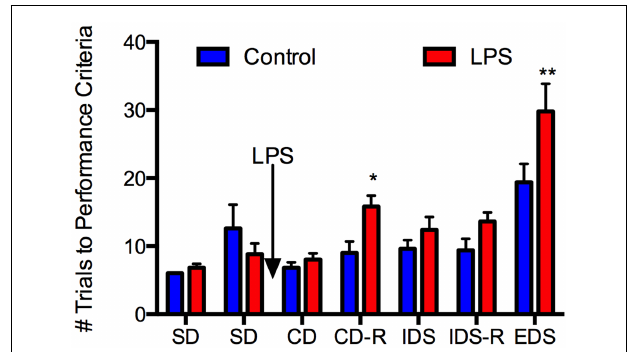
FIGURE 3 | Lipopolysaccharide selectively impaired attention/ executive function in aged rats .Twenty-four-month-old Fischer-344 rats ( N = 11) were tested on two simple discrimination (SD) tasks, one from each dimension (medium and shape) prior to receiving LPS 50 µ g/kg or an equal volume of saline i.p.They were tested on the compound discrimination (CD) task and compound discrimination reversal (CD-R) on day 1 after LPS, the intradimensional shift (IDS) and intradimensional shift reversal (IDS-R) on day 2 after LPS, and the extradimensional shift (EDS) on day 3 after LPS.There were no differences between the groups at baseline. LPS did not affect performance on the CD or IDS task but impaired performance on the CD-R and the EDS.This indicates LPS had no effect on simple discrimination learning but did impair attention/executive function for at least 3days. Data are mean ± SEM. * P ≤ 0.05, ** P ≤ 0.01 by two-way